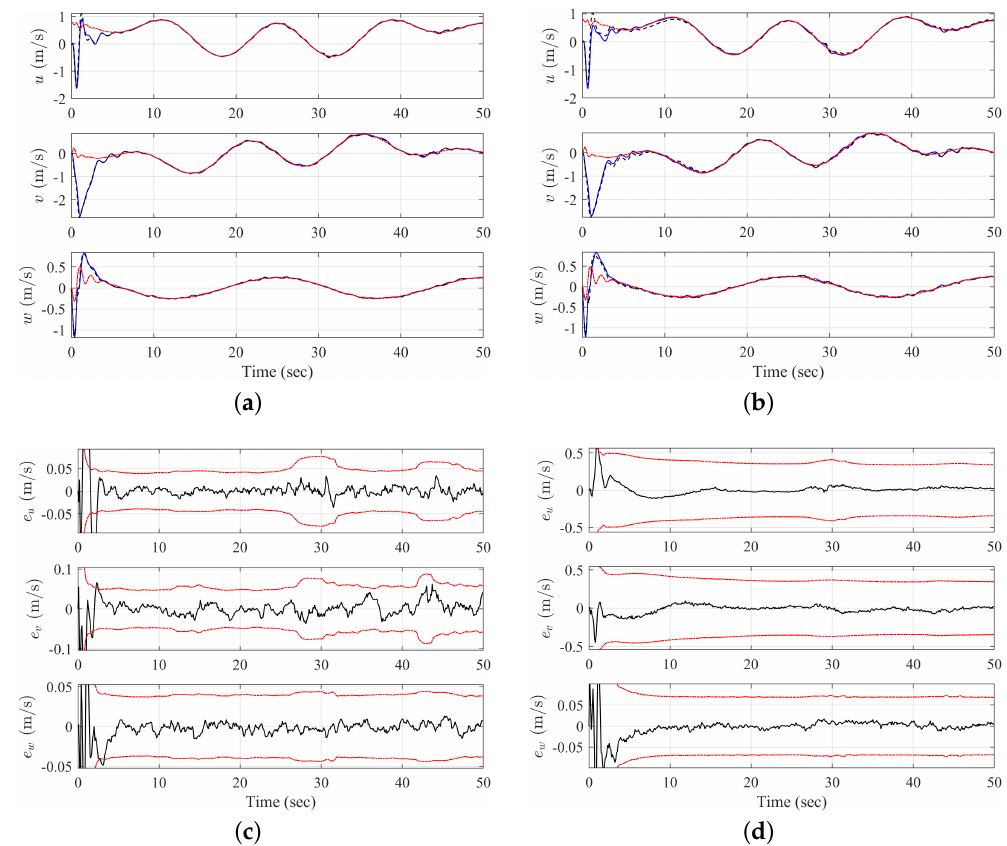
Figure 9. Quadcopter’s estimated velocity and corresponding estimation error when following an 8-shape trajectory for different cases. For ( a ) position for known landmarks and ( b ) posi- tion for unknown landmarks, true states ( ), estimated states ( ), and desired states ( ). For ( c ) estimated position error for known landmarks and ( d ) estimated position error for unknown landmarks, estimation error ( ), and 3 σ boundary (